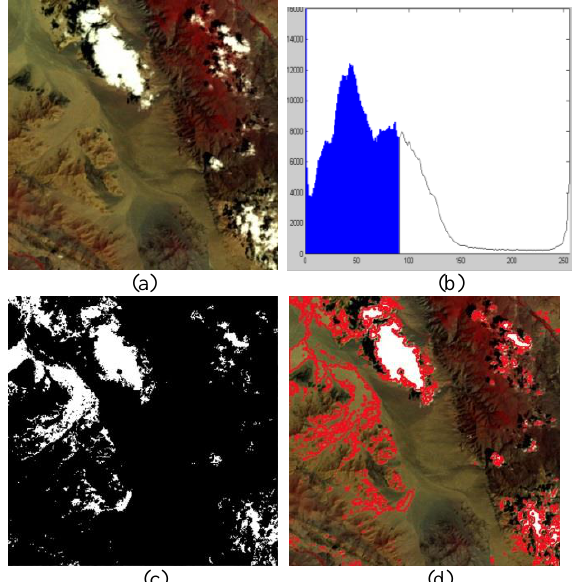
Figure 12. Threshold detection result. (a) Input image. (b) Cloud detection result based on tradition threshold method. (c) Binary cloud detection result based on proposed threshold method (d) Cloud detection result based on proposed threshold method